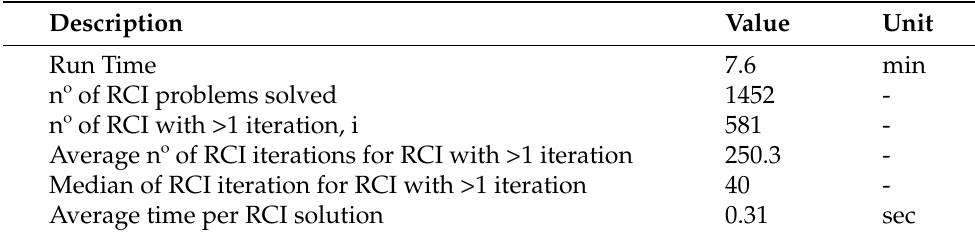
Table 3. Results of a simulation of a day. A 12-Bus